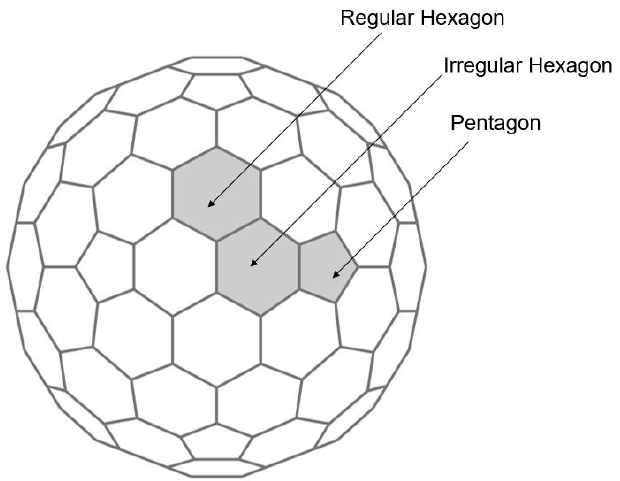
Figure 1. Goldberg polyhedron (3,0) used as the basis for PMSSM stator design. Highlighted are the fundamental geometries: pentagon (12 total), regular hexagon (20 total) and irregular hexagon (60 total).